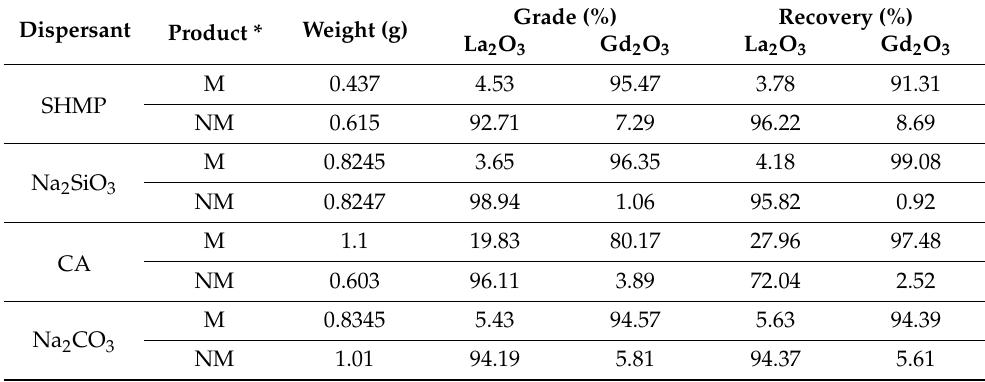
Table 1. Results of HGMS with four kinds of dispersants added in water.